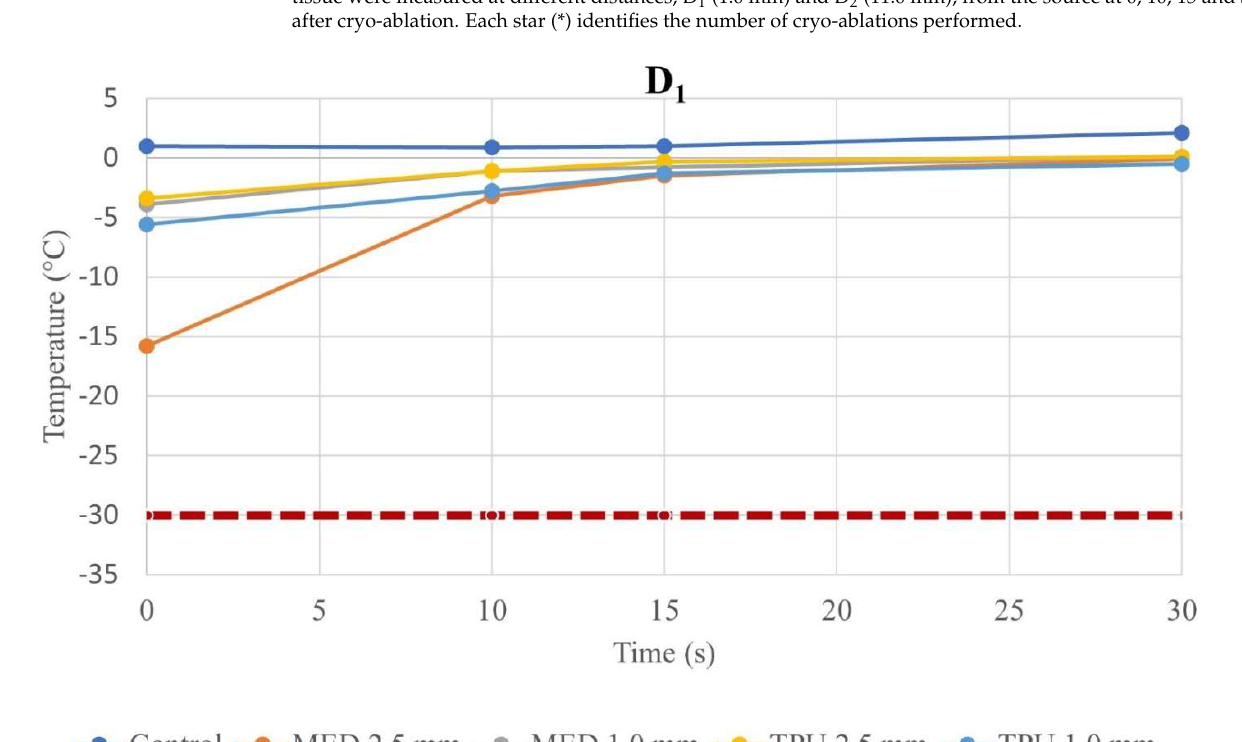
Figure 4. Temperature–time curve of control and biomaterial samples in D 2 . The graph represents the temperature–time curve at D 2 from the cryoablation catheter of the control, MED625FLX and